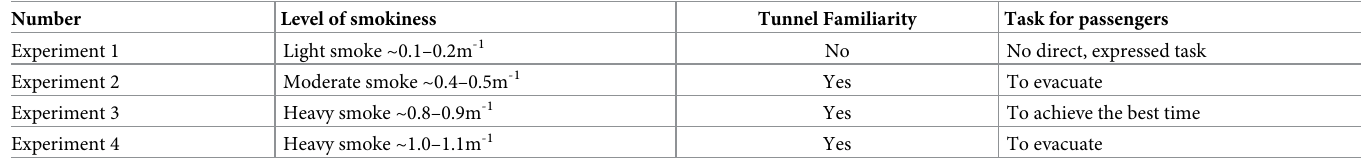
Table 1. List of experiments with different levels of visibility, tunnel familiarity of group of participants evacuated and expressed task. Number Tunnel